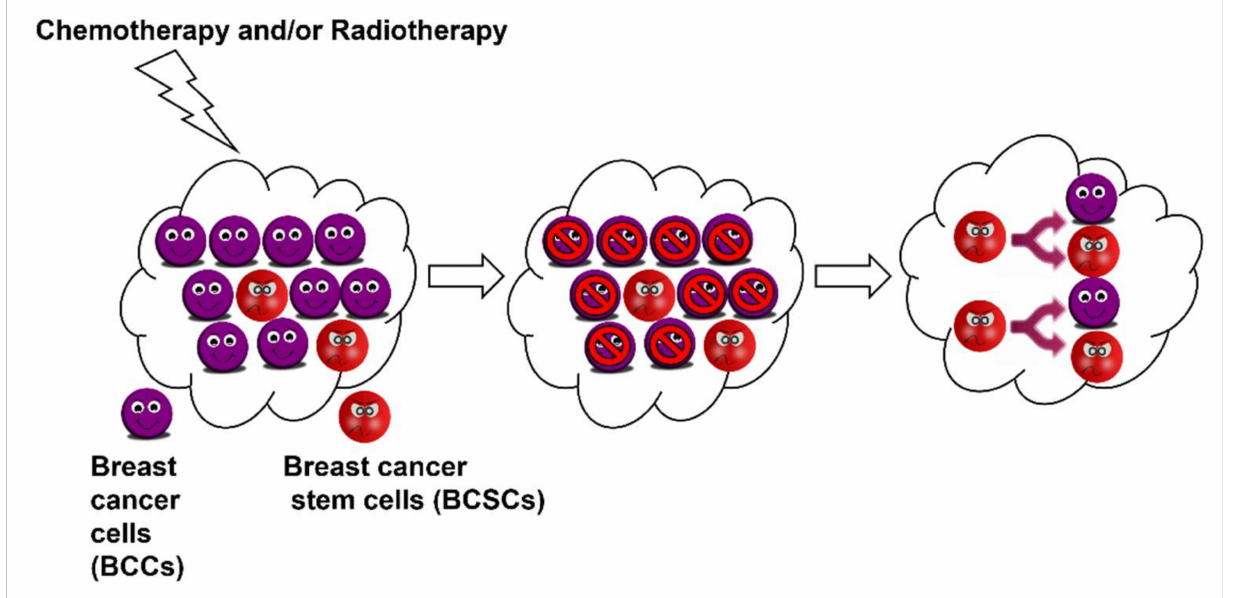
Figure 1. Breast cancer stem cells, or cancer-initiating cells, display an innate ability to evade and survive all treatment strategies owing to their stem-like properties. They function to maintain the cancer cell population while regenerating themselves